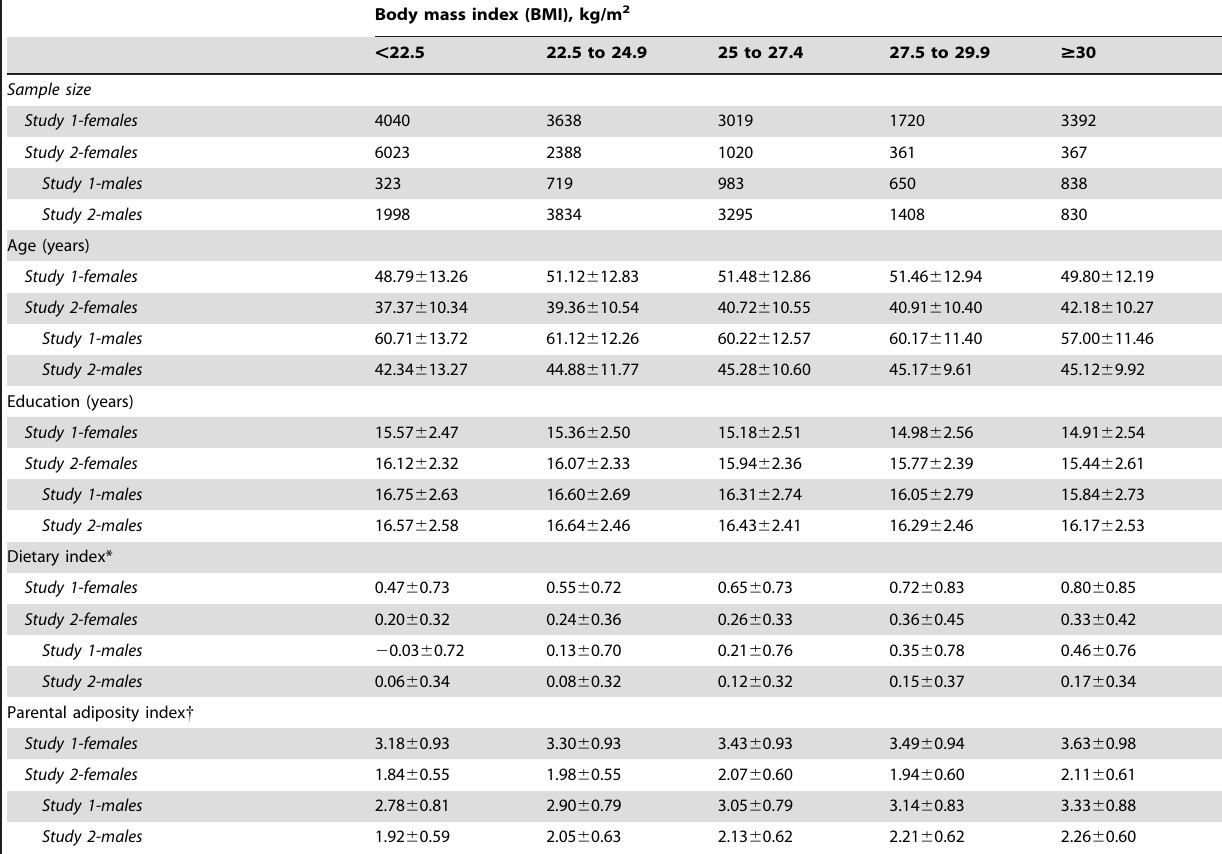
Table 2. Characteristics of the samples by body mass